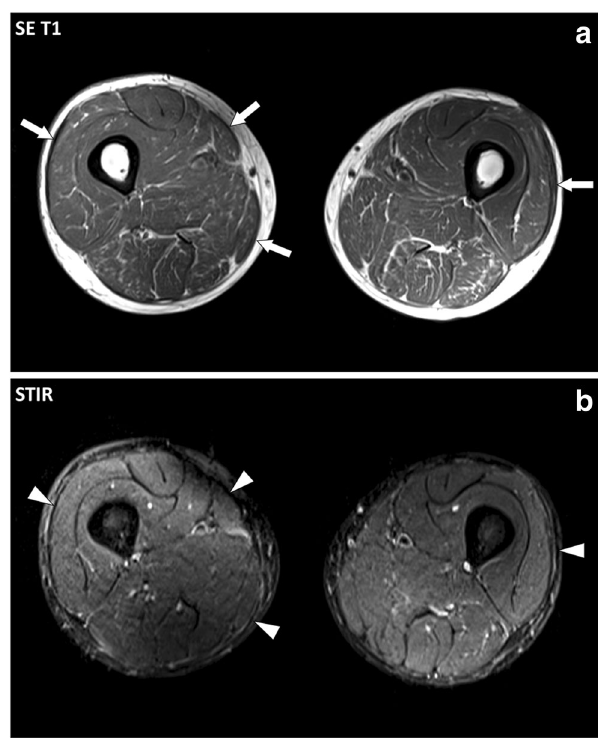
Fig. 11 Axial ( a ) SE T1-weighted and ( b ) STIR images of the thighs of a 52-year-old male with eosinophilic fasciitis treated for a year. MRI demonstrates thickening (arrows) of the deep peripheral fasciae with low signal intensity on STIR images (arrowheads) suggesting